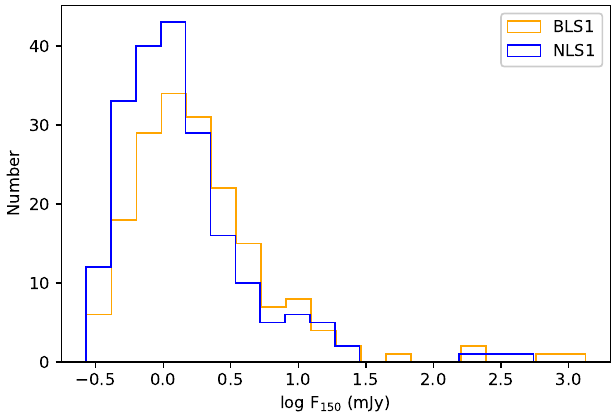
Figure 1. The distribution of 150 MHz radio flux for LoTSS detected NLS1s and